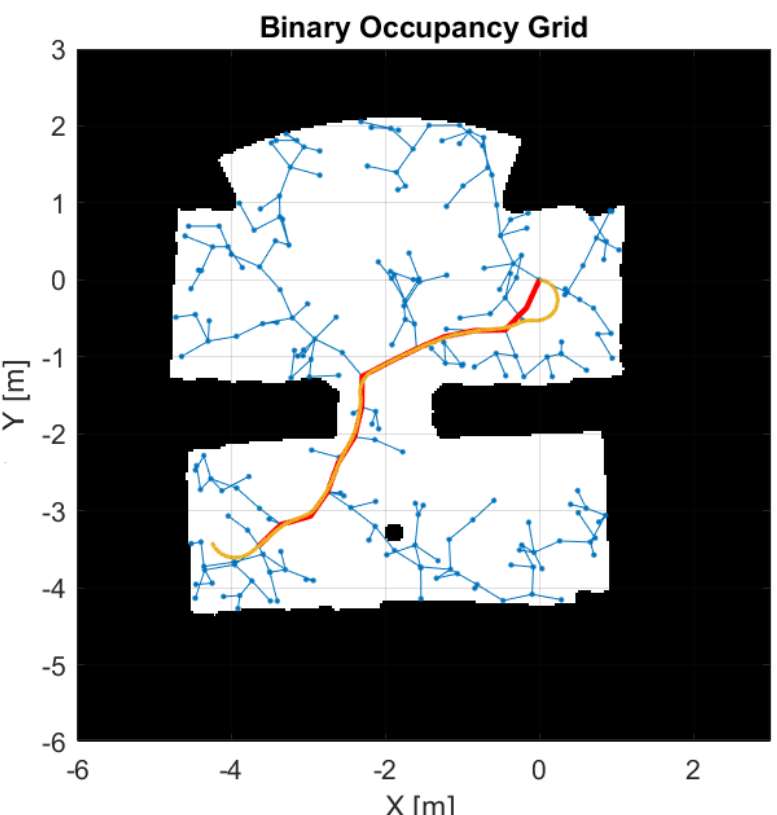
Figure 21. Desired waypoints obtained with RRT star algorithm and path obtained from odome- try data.